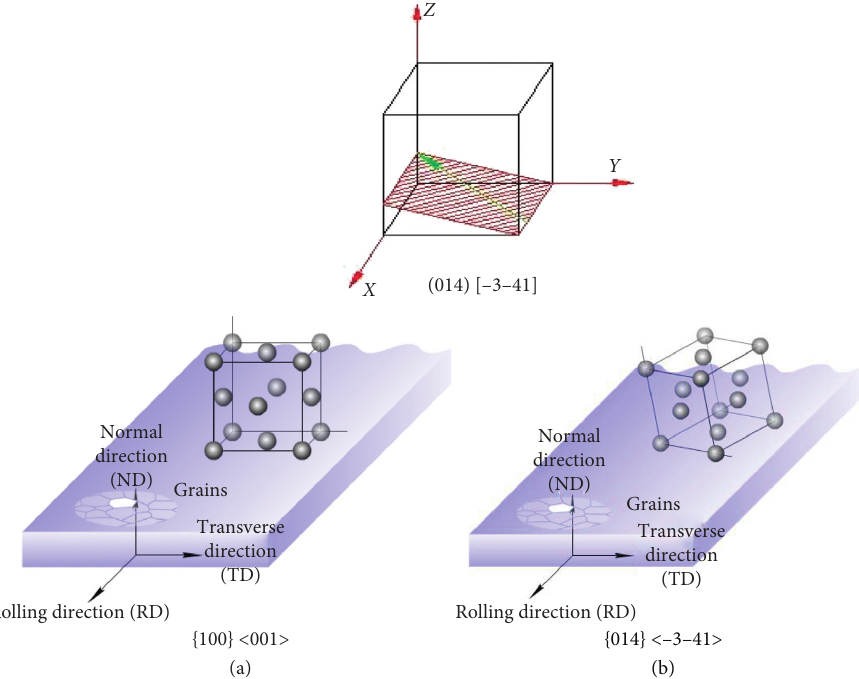
Figure 11: The orientation of the abnormal grain in the billet. (a) The normal grain at the surface of the billet. (b) The abnormal